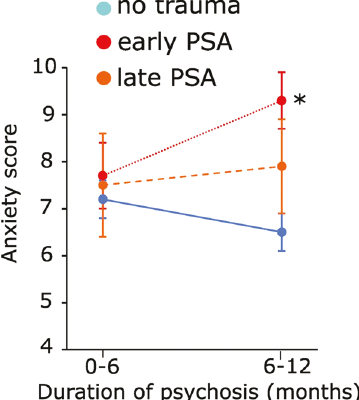
Fig. 5 Anxiety score in early psychosis male patients (EPP) with no reported trauma, early physical/sexual abuse (PSA) ( fi rst exposure before 12 years old), and late PSA ( fi rst exposure between 12 and 16 years old). Anxiety was assessed less than 6 months after psychosis onset and/or 6 – 12 months after psychosis onset. Data are represented with mean and standard error of measurement. *Indicates signi fi cantly different level of anxiety in EPP with early PSA as compared to EPP with no trauma (see text for more on statistical